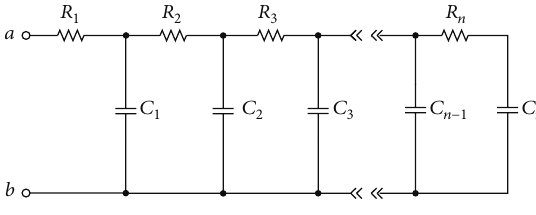
Figure 7: Capacitance scheme of